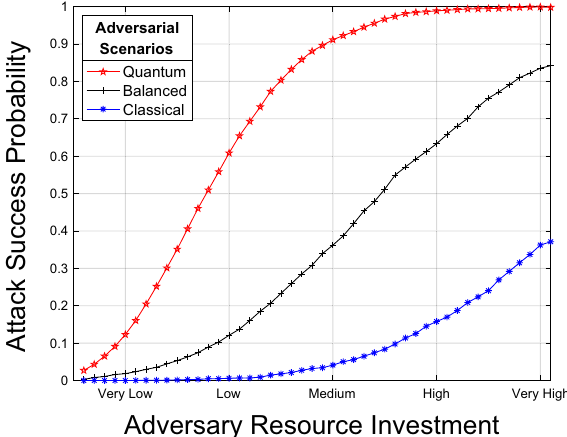
Figure 1. Attack success probability vs. adversary investment. We consider three adversarial scenarios. Classical (blue curve), where the resources of the adversary are lower than the resources of the defender. Balanced (black), where the resources of the defender are proportional to those of the adversary. Quantum (red), where the resources of the adversary are higher than those of the defender. Simulation code is available at the companion github repository, in the Matlab code folder 19